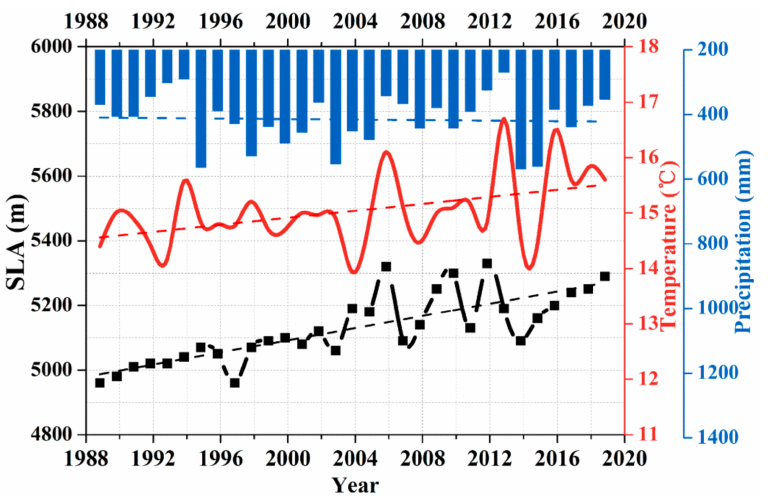
Figure 13. Summer precipitation (blue), summer mean temperature (red), and glacier SLA (black) across Gongga Mountains during the 1989–2019 period. Dashed lines indicate the best-fit linear trends for each dataset.